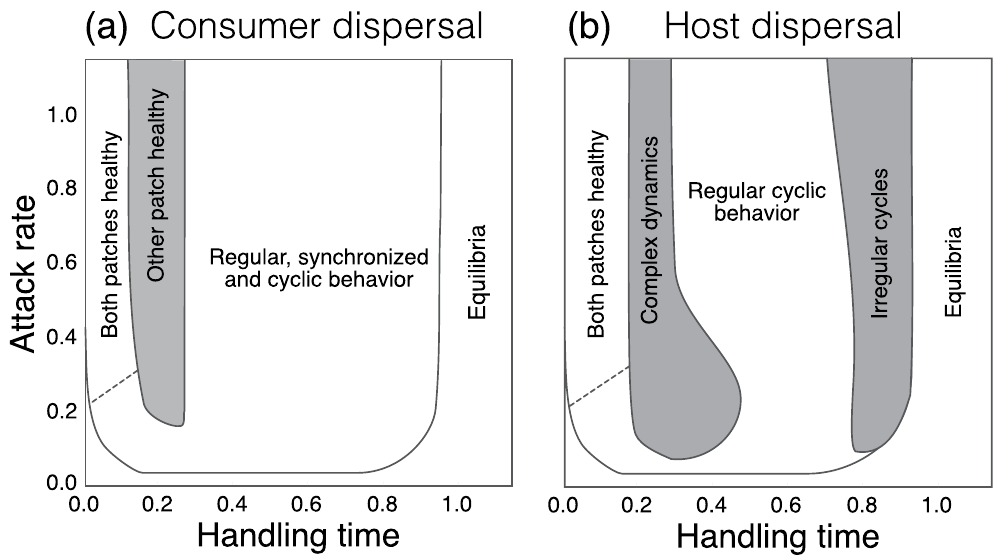
Figure 2. The effect of varying handling time and attack rate on host-pathogen dynamics. In general, cycle lengths increase when a handling time is longer. With a short handling time aggressive consumers make the system disease free, whereas almost all hosts are infected if the handling time is long. ( a ) Areas of different dynamics with the consumer dispersal rate of 0.25 (a large value selected to maximize the effect). ( b ) Areas of various dynamics with respect to the host dispersal rate of 0.1. While parameter values κ = 4 and λ = 0.5 were used to produce contrasting patterns, a large range of κ and λ values produces similar dynamical partitions. The dotted line describes a gradual shifting from one dynamics to another and solid borders show an abrubt change in a dynamical behavior. The drawn plots are based on simulation runs with a single representative initial value setting ( S 1 = 90, I 1 = 0, P 1 = 100, Q 1 = 200, S 1 = 10, I 1 = 0, P 1 = 100, Q 1 = 10). Initial values have influence on shifts between different dynamics and therefore these plots give only approximate dynamical ranges. Hence, near the border area of two different dynamics, the system may end up either of stabilized dynamics depending on the initial balance between different